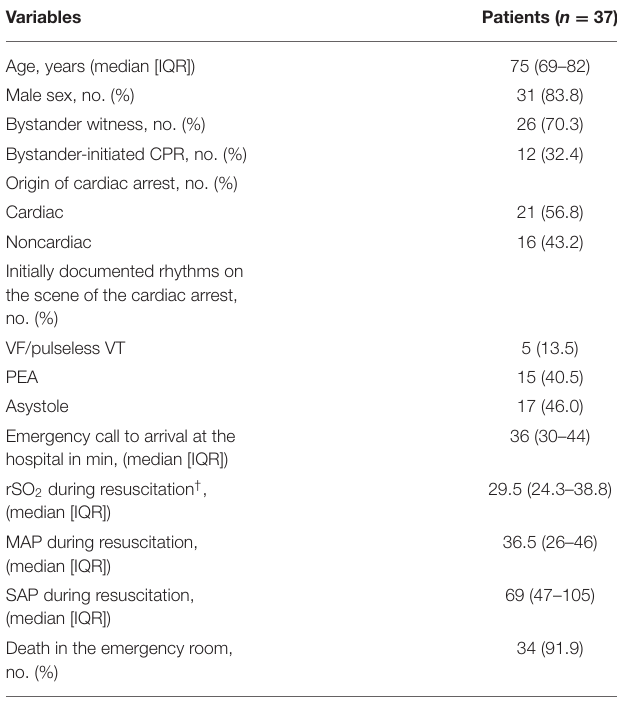
TABLE 1 | Baseline characteristics of all the analyzed